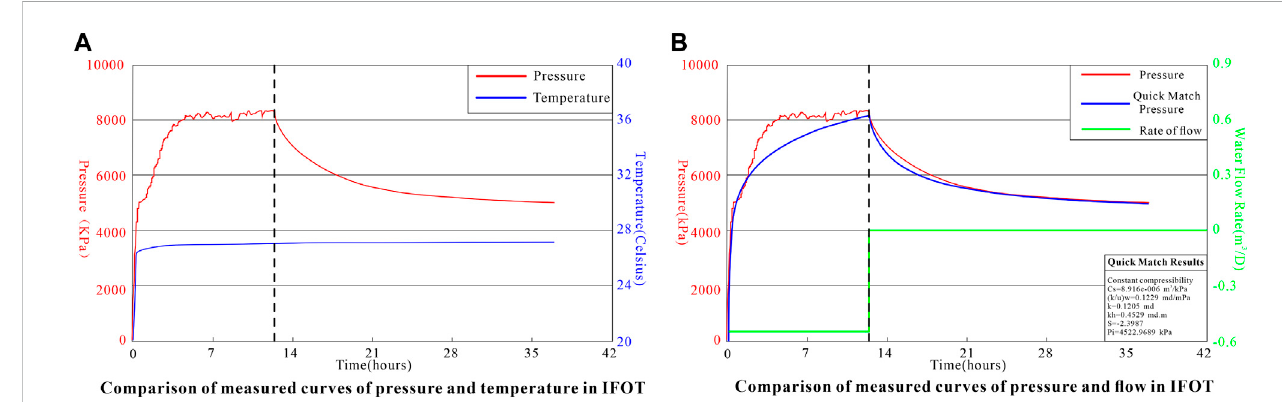
IFOT parameter diagram of 10 # coal seam in Jinjia